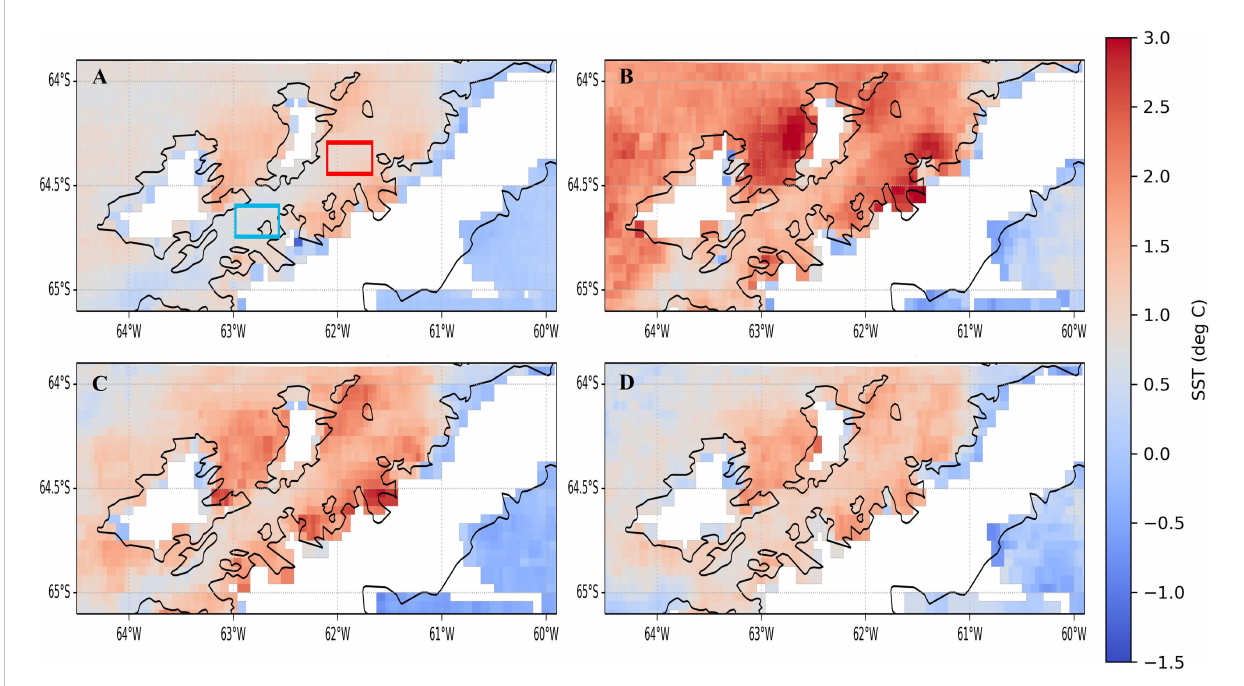
FIGURE 2 Sea surface temperature (SST) average maps created with Aqua/MODIS data for consecutive summers (December-February): (A) decadal observations, 2011-2021, (B) S1, 2016-2017, (C) S2, 2017-2018, and (D) S3, 2018-2019. December-February were chosen for SST data